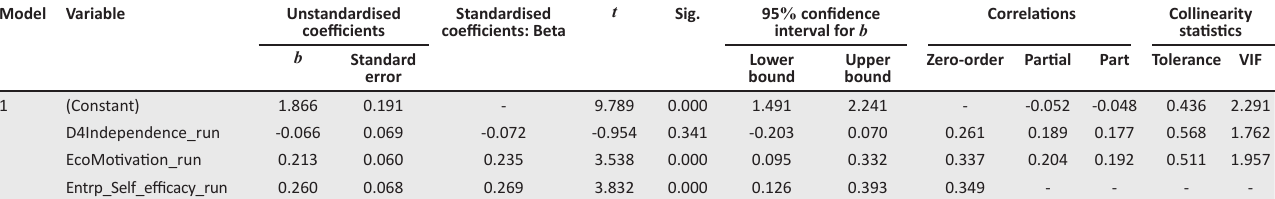
TABLE 3-A1: Coefficients † . Model Variable